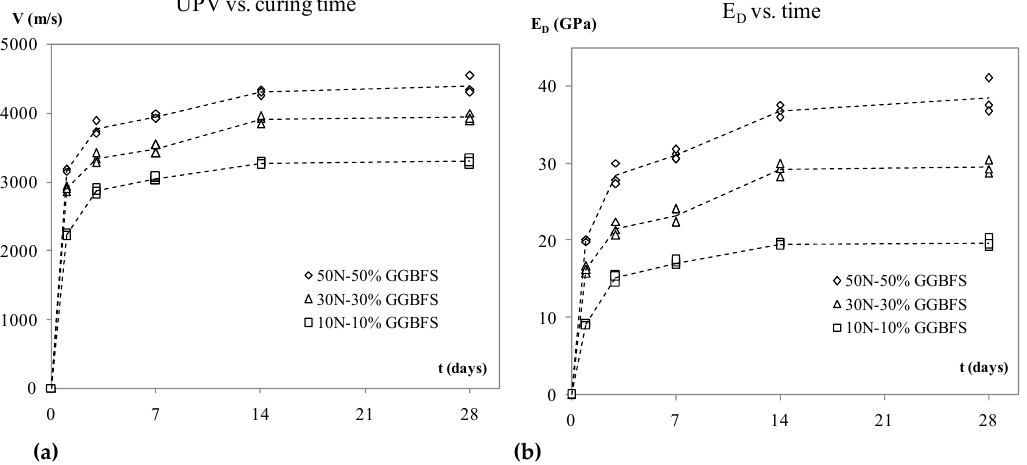
Figure 5. ( a ): Evolution of UPV as a function of curing time ( b ): Dynamic modulus of elasticity E d as a Figure 5. (a): Evolution of UPV as a function of curing time (b): Dynamic modulus of elasticity E d as function of curing a function of curing time.